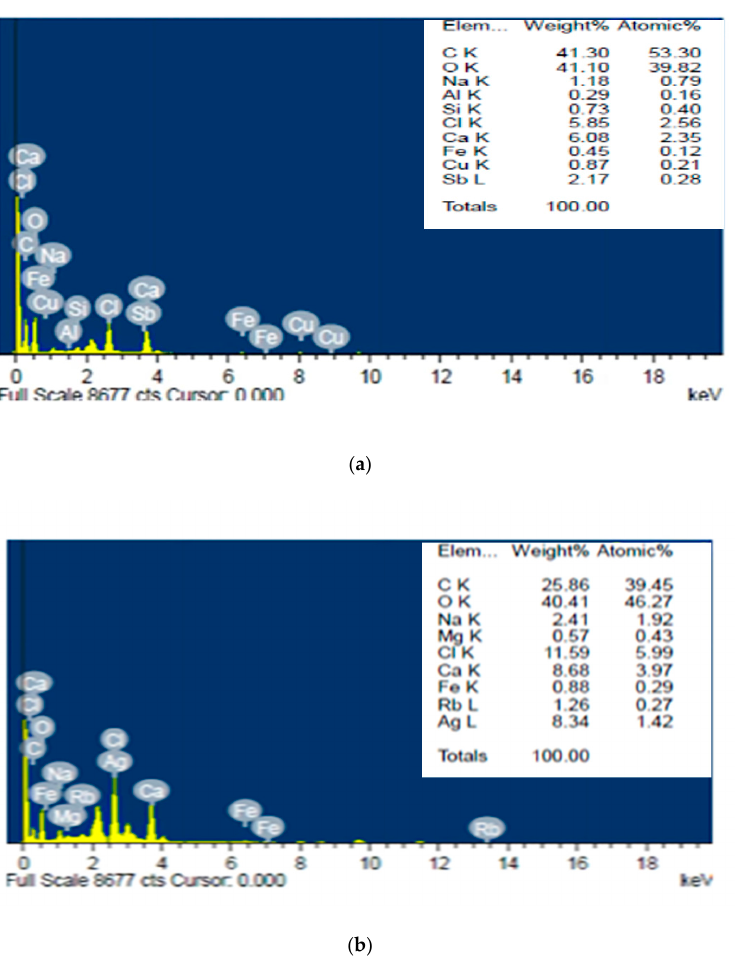
peaks of XRD diffraction patterns of Ulva/Ag/cellulose nanocomposites were recorded at 2 θ , 20.6, 23.2, 27.7, 28.9, 29.5, 30.9, 31.6, 32.1, 36.2, 37.2, 43.3, 45.4, 47.5, 49.0, 54.6, 55.8, 56.4, 57.3, 58.2, 66.0, and 67.3. The main crystalline peak was obtained at 2 θ (32.1°) with an intensity of 100% and crystalline size of 31.35, and all peaks were sharp and all crystalline sizes in nm, which confirmed the crystalline Ulva/Ag/cellulose nanocomposites (Figure 6b and Table 2b). When the diffraction peak is quite sharp, which indicates that the silver has good crystallization performance [73] The diffraction peaks at 38.1°, 44.19°, 64.4°, and 77.4° corresponding to lattice planes (hkl) from the (111), (200), (220), and (311) crystal- lographic planes of cubic AgNPs [74]. The XRD analysis of neat CNF-Ag NPs composites revealed the presence of Ag nanoparticles with the peaks at 2 θ = 37.68°, 43.97°, 64.12° and 77.22° which are corresponding to (111), (200), (220), and (311) in the region from 20 to 80° [75]. Figure 5. Energy-dispersive X-ray spectrophotometry analysis of biosynthesis: nanocellulose ( a ) and Ulva/Ag/cellulose nanocomposites ( b ) derived from U. lactuca .